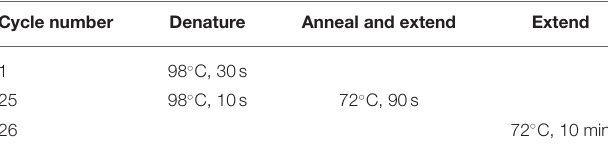
( Figure 2D ). The V:I = 1:3 reaction showing the highest intensity of the high molecular weight band (corresponding to the total length of vector and insert) was selected for